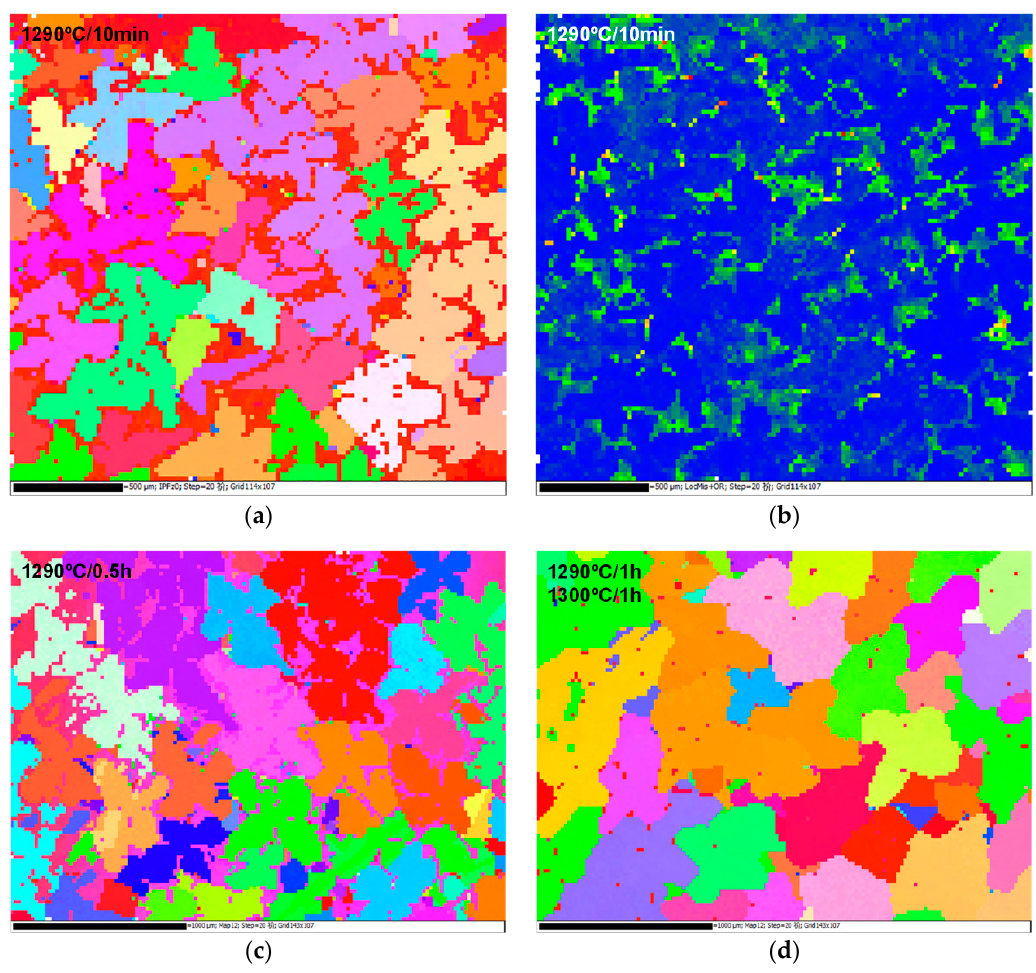
Figure 9. Electron backscattered diffraction (EBSD) results of S-980: ( a ) S-980-1 inverse pole figure (IPF); ( b ) S-980-1 local misorientation map (KAM) ; ( c ) S-980-2 IPF ( d ) S-980-3 IPF.